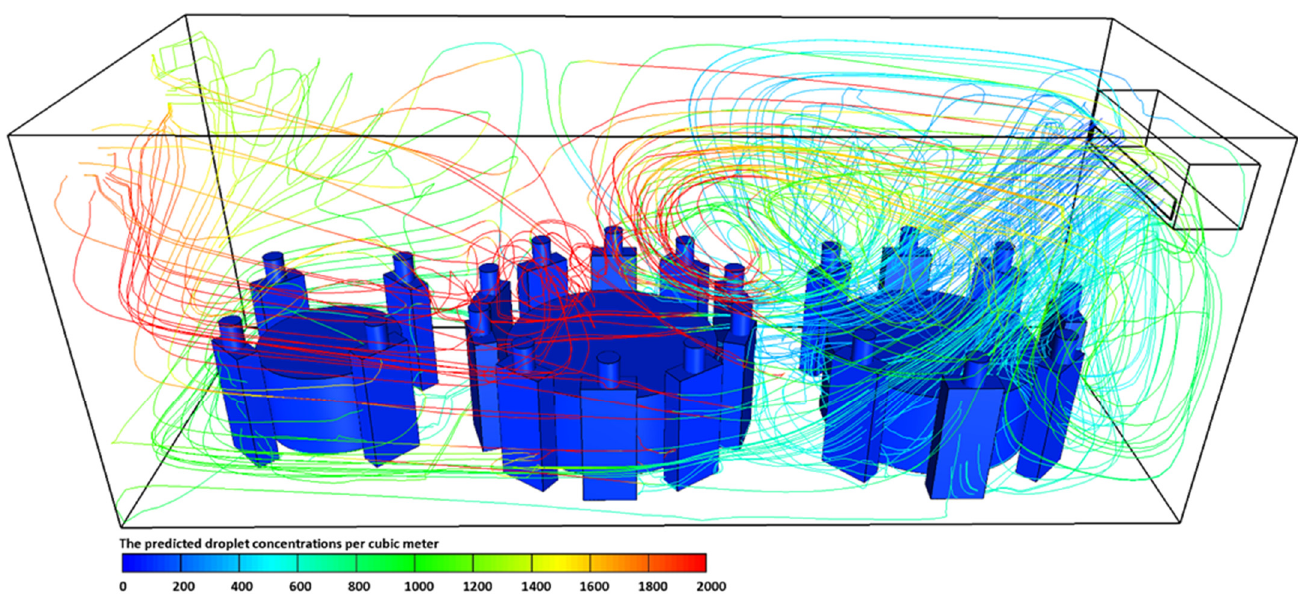
Figure 8. The predicted droplet concentrations per cubic meter exhaled from index case (T2C1) at t = 4500 s for case-4.